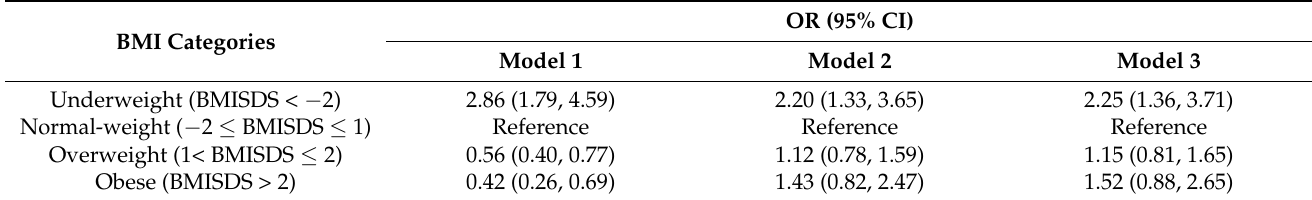
Table 2. Individual prediction of BMI categories for low IGF-1 levels.